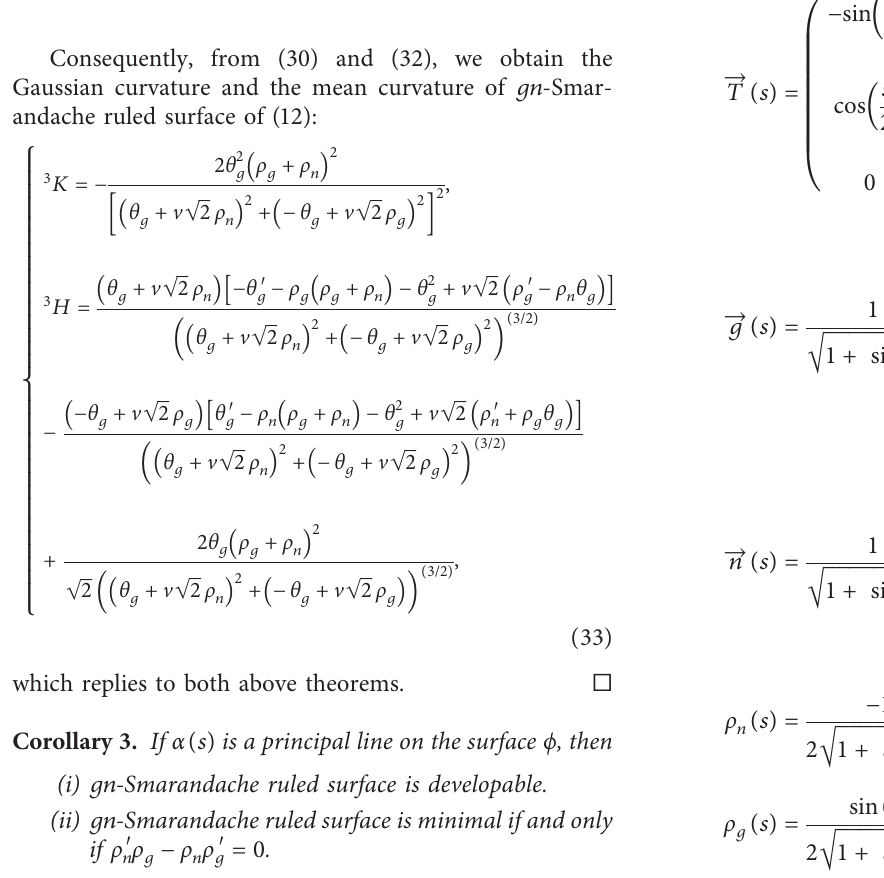
Figure 2: Tn -Smarandache ruled surface (37).